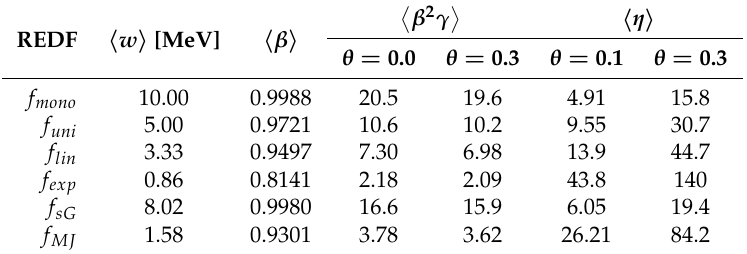
Table 1. Comparison of parameters (RE energy w , relativistic β , the term from Equation (3) (cid:68) (cid:69) (cid:11) + 0.5 (cid:10) β 2 β 2 γ and drift term η for W max estimation) averaged over w for different ⊥ γ (cid:107)